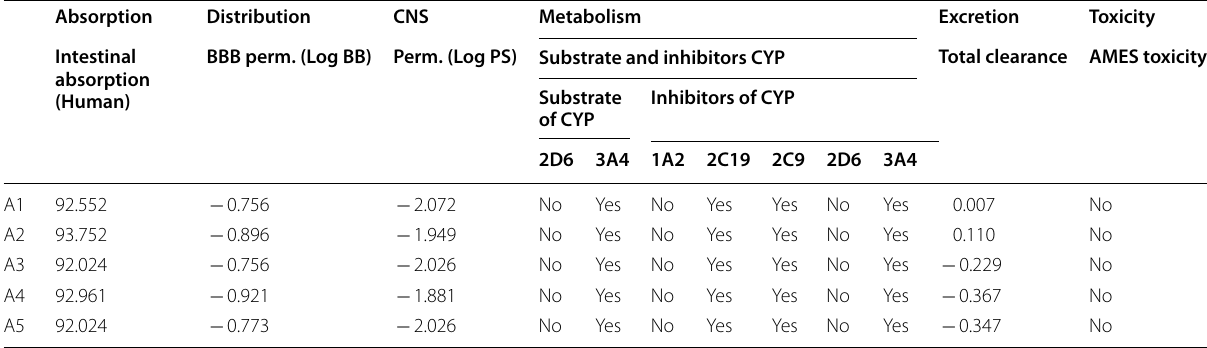
Table 7 ADMET properties of the designed analogues Absorption Distribution